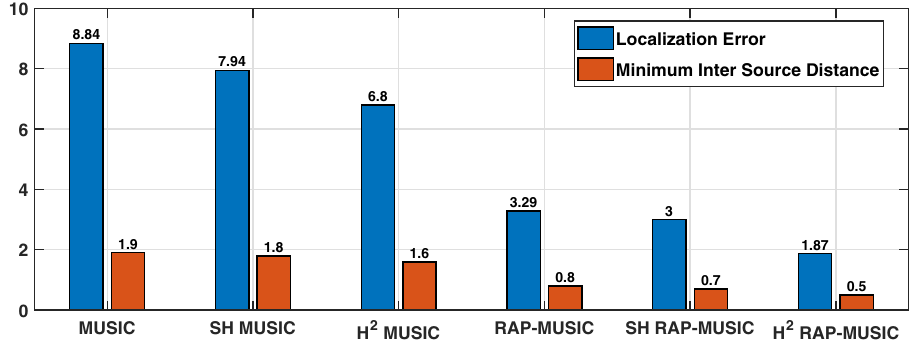
Figure 4. Spatial resolution.